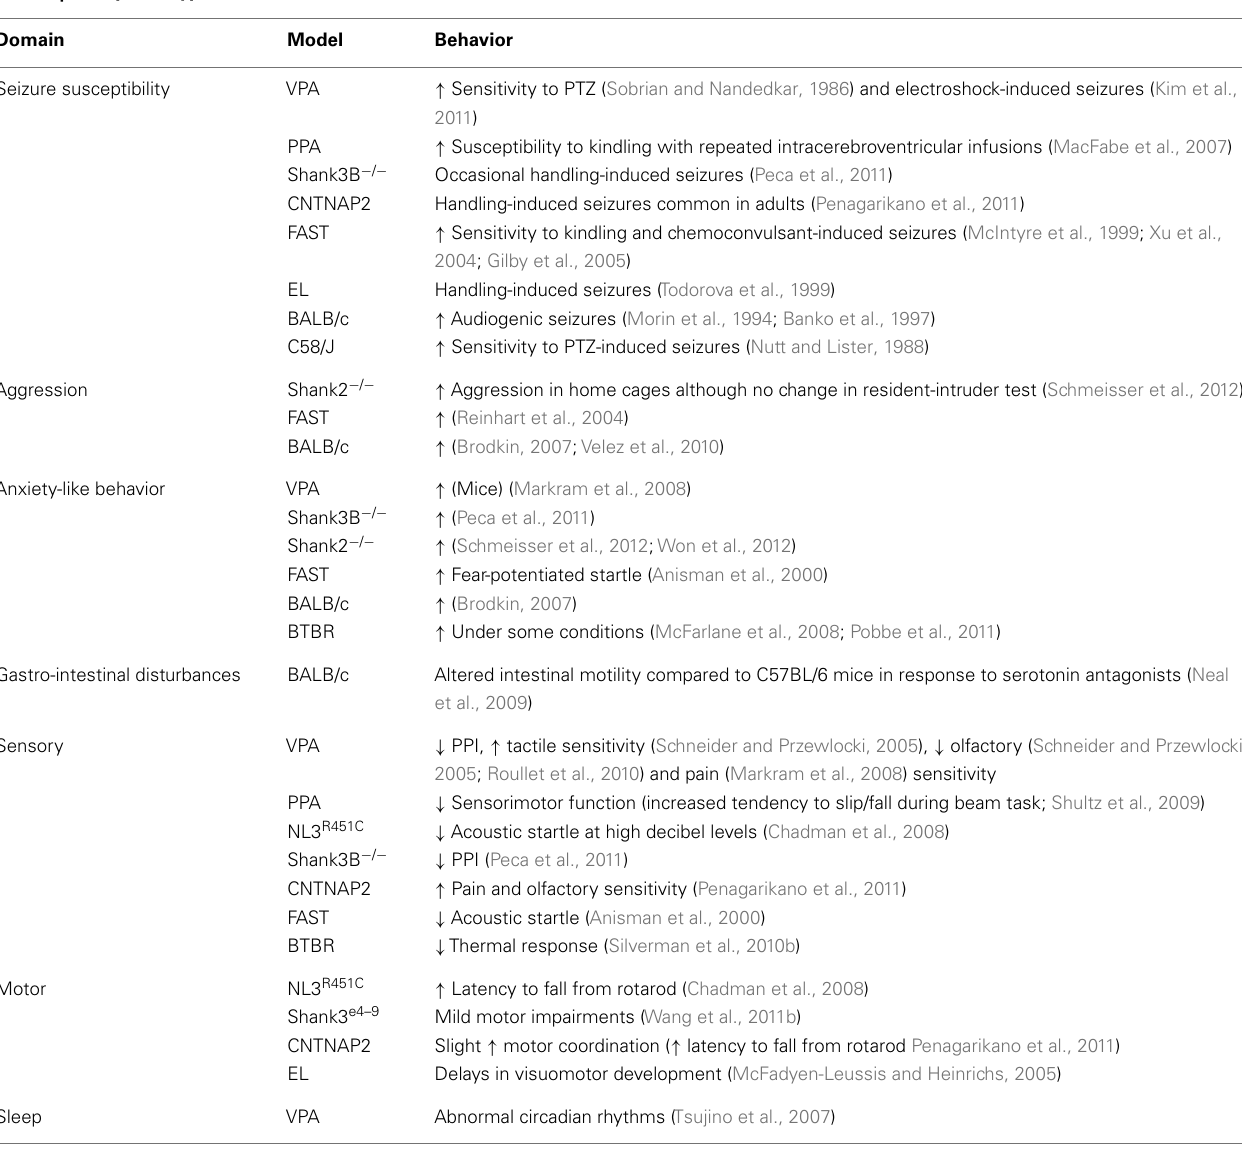
Table 2 | Endophenotypes identified in rodent models relevant to comorbid features ofASD.